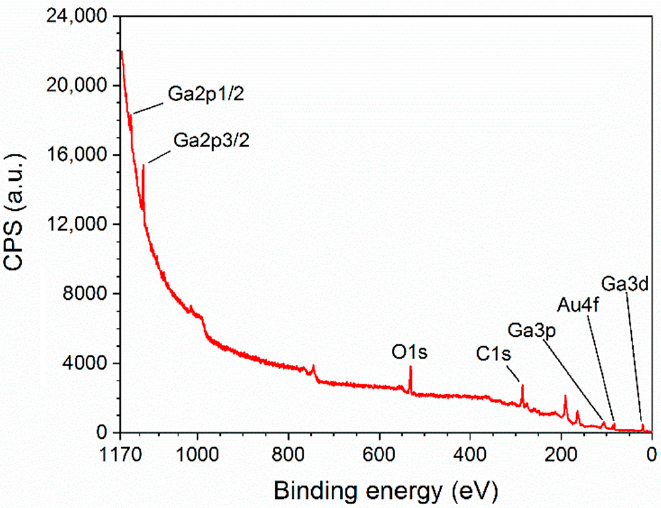
Figure 11. Survey spectrum of β -Ga 2 O 3